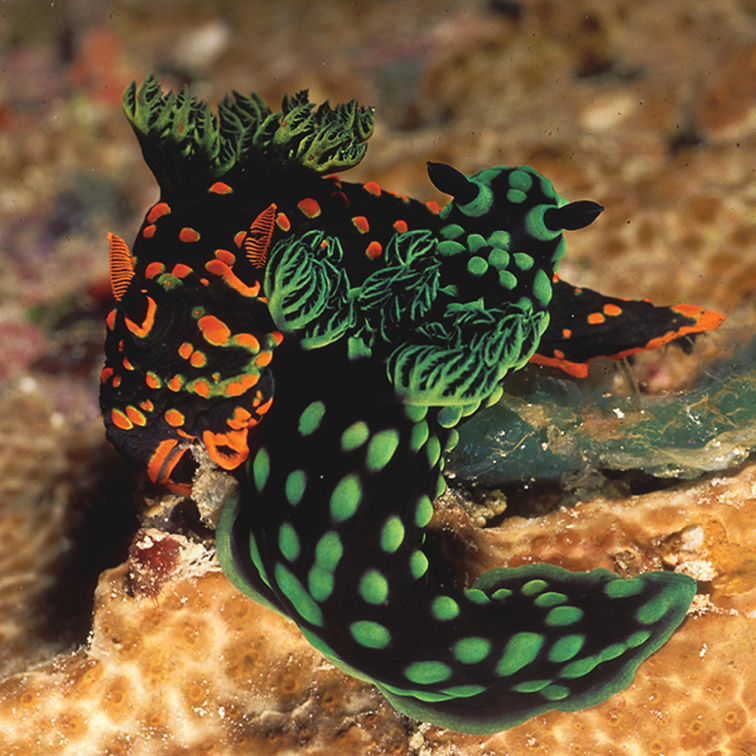
Nembrotha guttata, Maldives, photo: H Voigtmann (with N. cristata, no spcms).